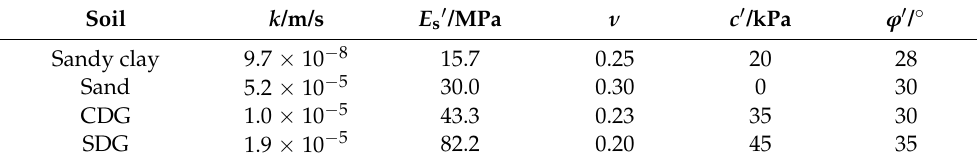
Table 3. Parameters of the Mohr–Coulomb model.